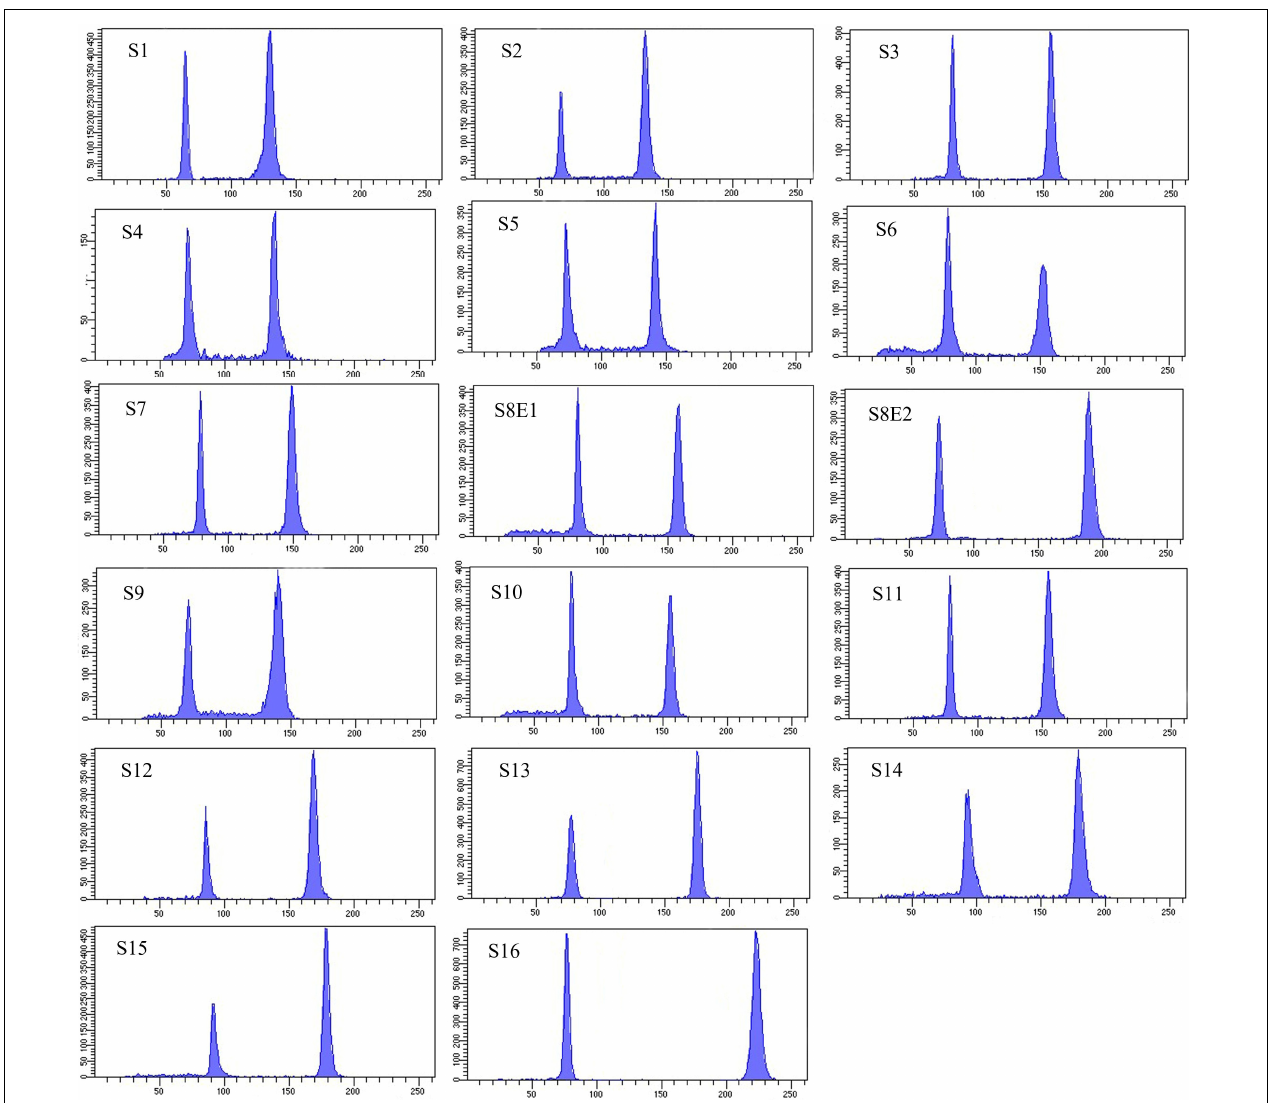
FIGURE 6 | Histograms of flow cytometric 2C DNA content of 17 populations of 16 Pimpinella species. The left peaks refer to the Solanum lycopersicum cv. Stupick (2C DNA = 1.96 pg) internal reference standard and the right peaks to the Pimpinella samples. The x -axes are fluorescence intensity and the number of nuclei, respectively. S1 ( P. affinis ), S2 ( P. eriocarpa ), S3 ( P. tragium ), S4 ( P. saxifrage ), S5 ( P. aurea ), S6 ( P. tragioides ), S7 ( P. olivieri ), S8 ( P. khayyamii ), S9 ( P. kotschyana ), S10 ( P. deverroides ), S11 ( P. olivierioides ), S12 ( P. anthriscoides ), S13 ( P. anisactis ), S14 ( P. peucedanifolia ), S15 ( P. khorasanica ), and S16 ( P. rhodantha